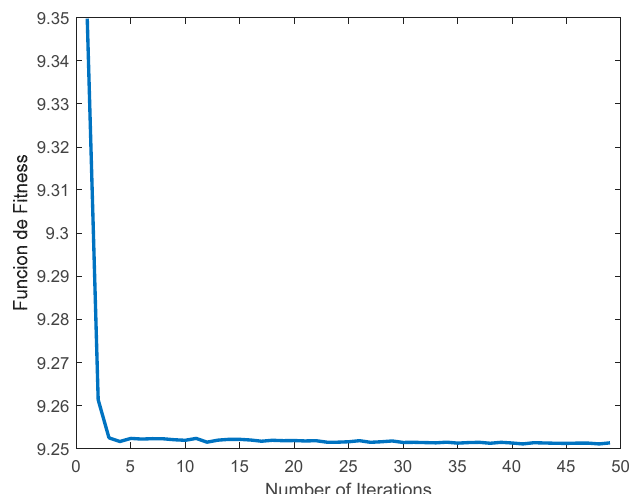
Figure 10. Evolution of the objective function or cost function 𝐽 (cid:3041)(cid:3042)(cid:3045)(cid:3040) as the number of iterations increases using PSO and FO-DMRAC. The best parameter values obtained for the FO-DMRAC case were